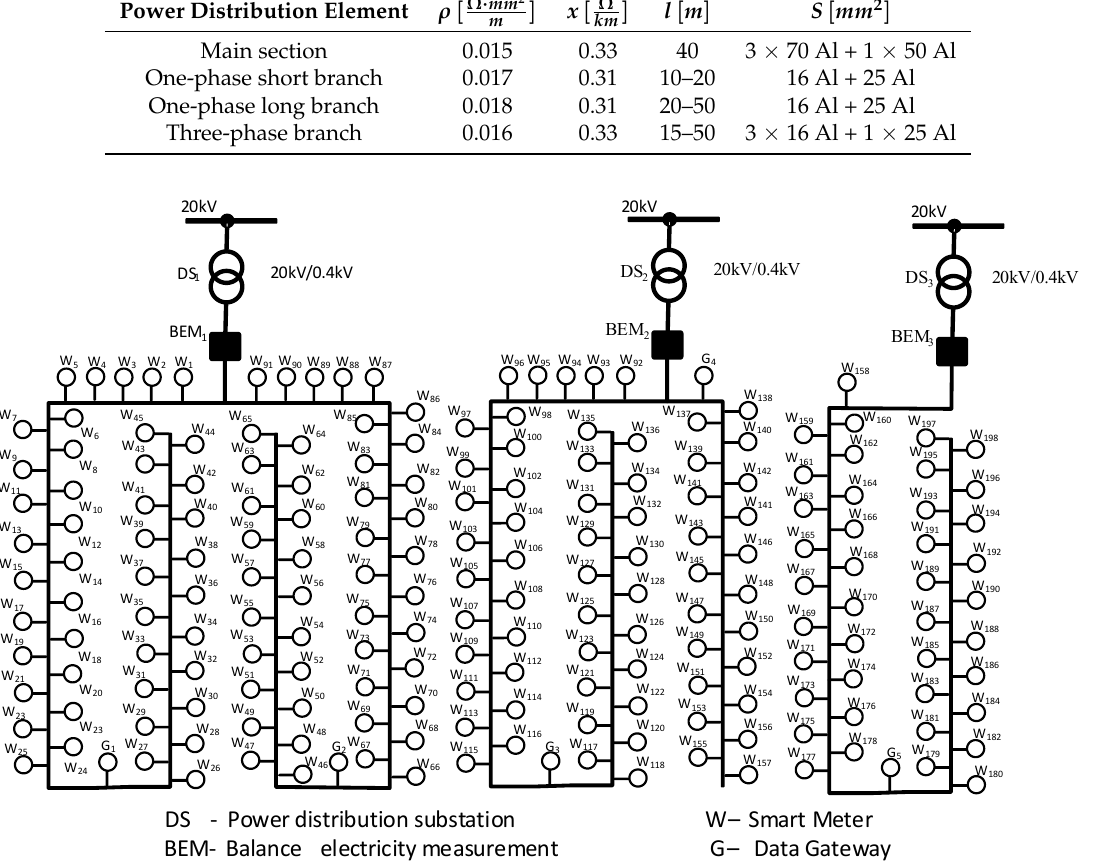
Figure 3. Smart metering system